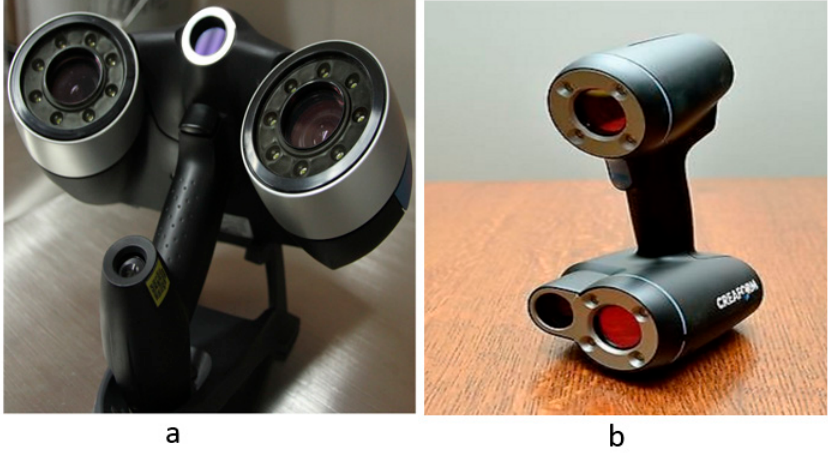
Figure 2. Handheld scanners ( a ) laser scanner; ( b ) white light scanner.